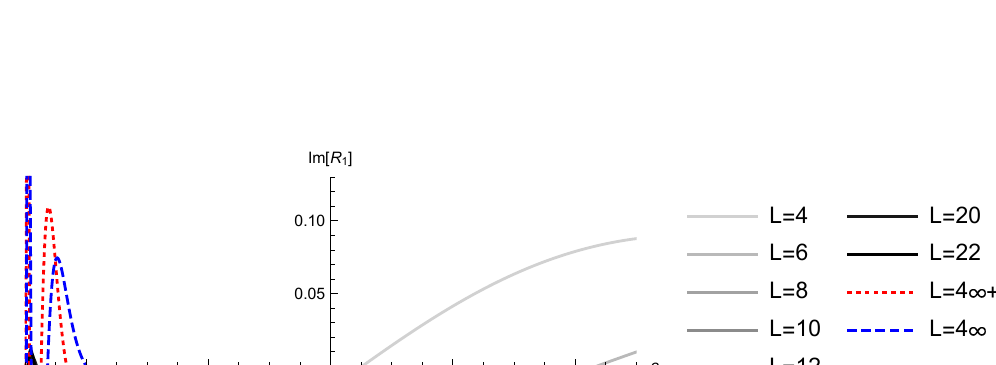
Figure 23 . Plots of the real part of R 1 (A.3) of Φ G dashed lines are extrapolations to L = 4 k + 2 ( k → ∞ ) and L = 4 k ( k → ∞ ), respectively. The horizontal axis denotes the value of the parameter a at Re R 1 = 1 .